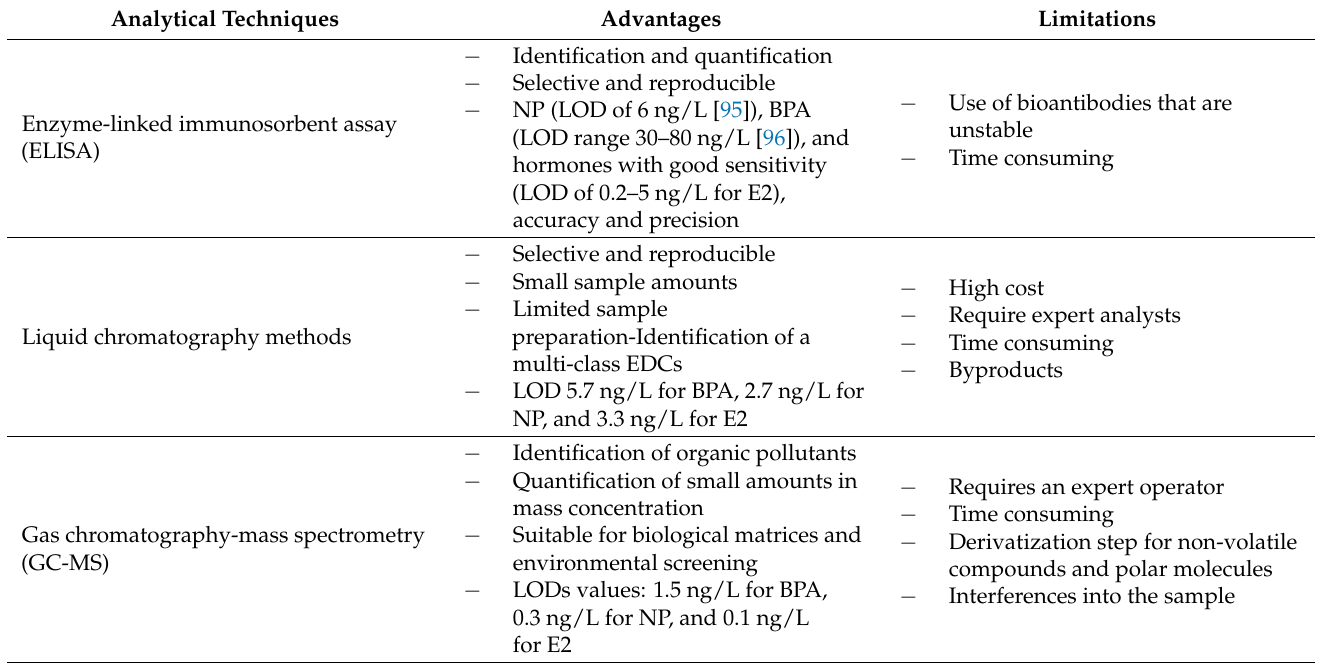
Table 2. Comparison of the main analytical methods for EDC detection. Analytical